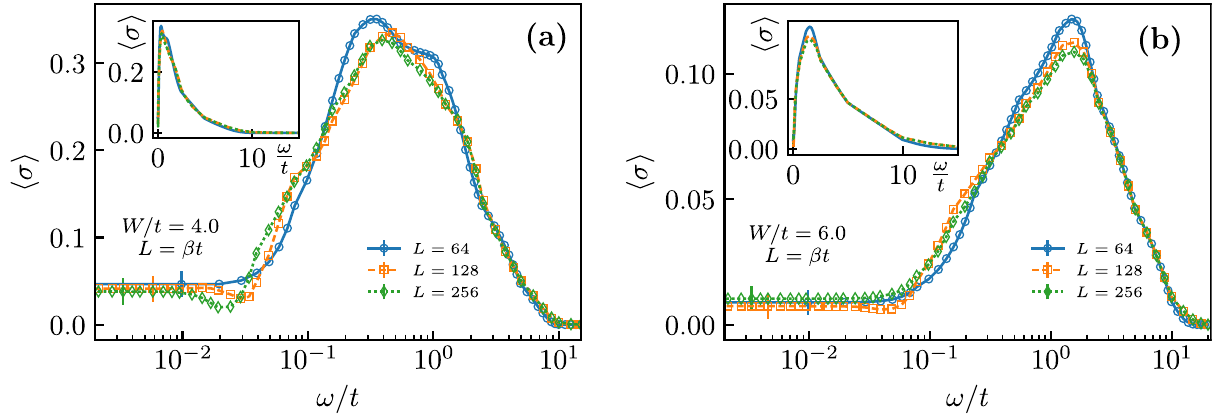
Fig. 3 Disorder-averaged optical conductivity. 〈 σ ( ω ) 〉 as a function of the frequency ω for a W = 4 and b W = 6, and for system sizes L = 64 (blue circles), 128 (orange squares), and 256 (green diamonds). Data in the main plots were shown on the logarithmic scale for the frequency, highlighting the behavior at small ω . Insets show data on a linear scale. Vertical error bars indicate uncertainty of the extracted optical conductivity as determined by the analytic continuation